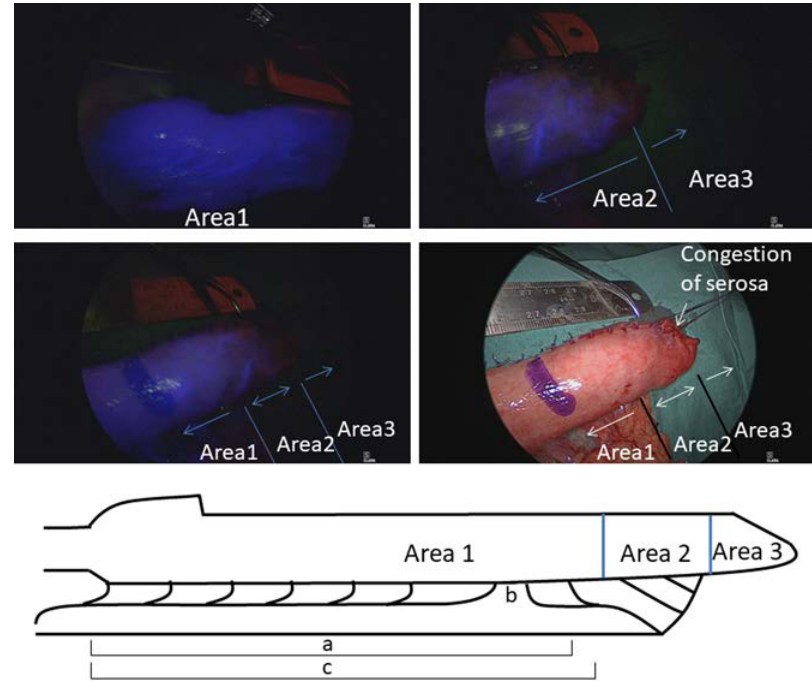
Figure 4 Blood perfusion of the 3-cm-wide gastric conduit as determined using the indocyanine green fluorescence method. Area 1, good perfusion; area 2, congestion; area 3, no perfusion Area 1 is promptly perfused, and the entire gastric wall is dyed. Area 2 is dyed more slowly than area 1, and only the blood vessels in the gastric wall are dyed. Area 2 is almost the same as a macroscopically congested site. In area 3, no dyeing is seen. (a) Length between the pylorus and the first branch of the left gastroepiploic artery. (b) Watershed. (c) Length of the gastric conduit